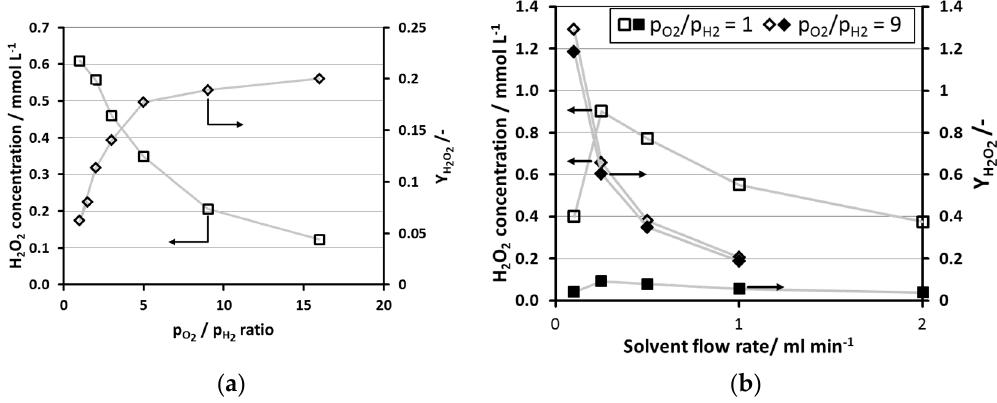
Figure 3. ( a ) Hydrogen peroxide concentration (squares) and hydrogen peroxide yield (diamonds) over partial pressure ratio of oxygen to hydrogen using Pd/TiO 2 in a micro channel fixed bed in a 0.5 mm deep micro channel and a 180 µ m Nafion ® membrane at 10 bars system pressure with water with additives as solvent (Table 1 Exp.-Nr.: 18–24). ( b ) Hydrogen peroxide concentration and hydrogen peroxide yield over solvent flow rate using Pd/TiO 2 in a micro channel fixed bed in a 0.5 mm deep micro channel and a 180 µ m Nafion ® membrane at 10 bars system pressure with water with additives as solvent: squares: pO 2 /pH 2 = 1 (Table 1 Exp.-Nr.: 13–17), diamonds: pO 2 /pH 2 = 9 (Table 1 Exp.-Nr.: